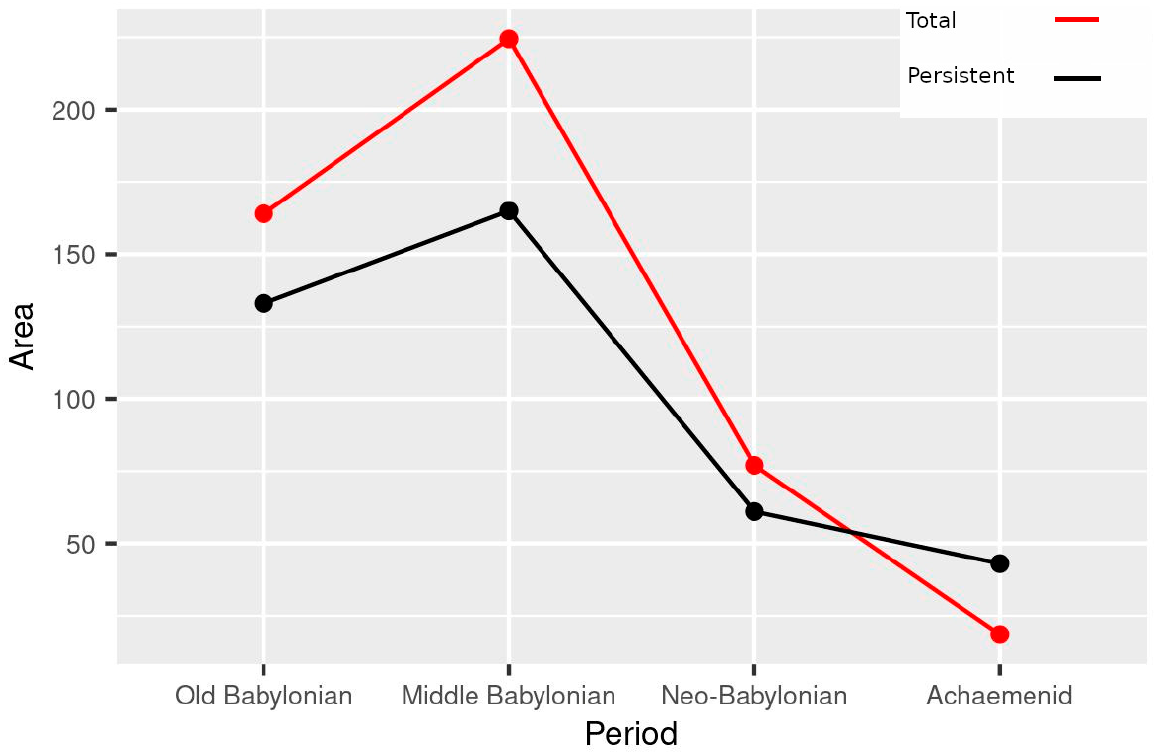
Figure 5. Total occupied area. Shows gross occupied area of all sites in each period, and specifically in those sites persisting between historical periods.